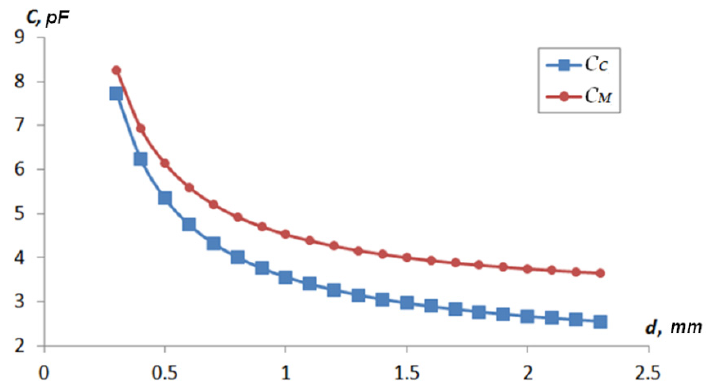
Figure 11. Type 1 sensor response function depending on the distance to the shaft surface.